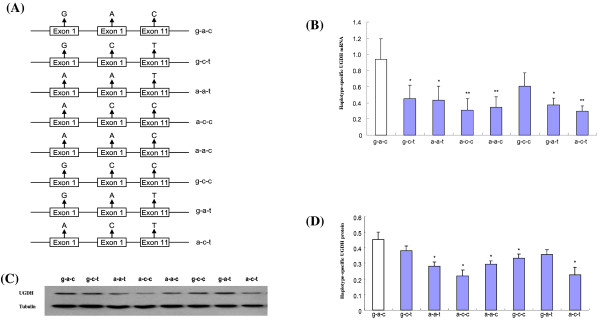
Expression analysis of all combinations of SNPs Ex 1–1, Ex 1–2 and Ex 11–1. (A) Illustration of eight haplotype constructs for UGDH. (B) Statistical analysis of real-time RT-PCR data for the eight plasmid constructs. 18sRNA was used to normalize expression of each construct. Compared with g-a-c, g-c-t, a-a-t, a-c-c, a-a-c, g-a-t, and a-c-t decrease the expression of UGDH, by 51.8%, 53.9%, 61.6%, 63%, 59.7% and 68.2%, respectively. (C) Representative Western blotting images for eight constructs of UGDH and β-Actin. (D) Statistical analysis of the protein level of eight constructs of UGDH normalized to β-Actin, which indicated a-a-t, a-c-c, a-a-c, g-c-c, and a-c-t similarly decreased UGDH protein expression, by 37.8%, 51.1%, 34.8%, 26.6%, and 50.1%, respectively, compared with the construct g-a-c. Values are given as means ± S.E.M. (* P <0.05, ** P <0.01; n = 5/group.